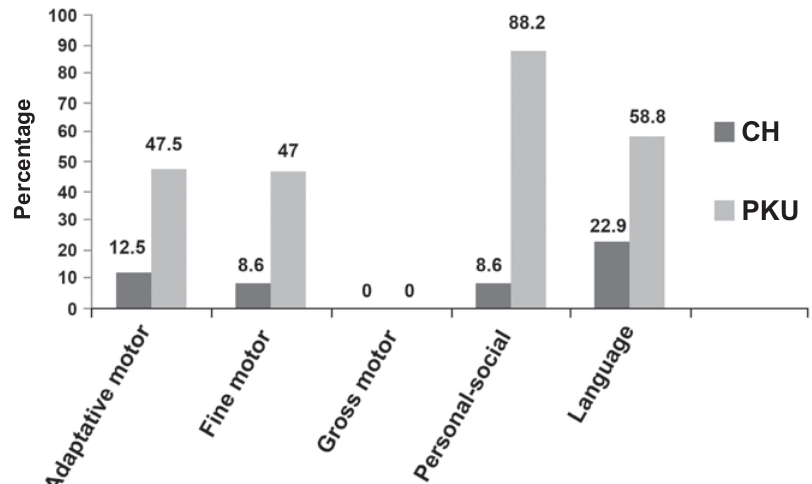
Figure 3- Percentage of children with alterations in the abilities of the GABDS